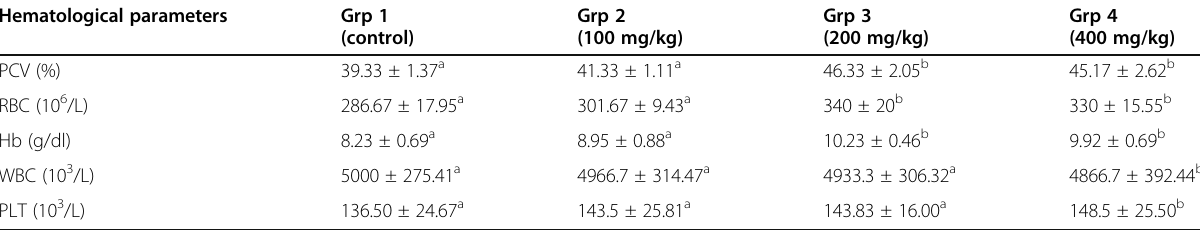
Data represent mean ± SD (n = 6); values with dissimilar alphabets as superscripts are significant at p <